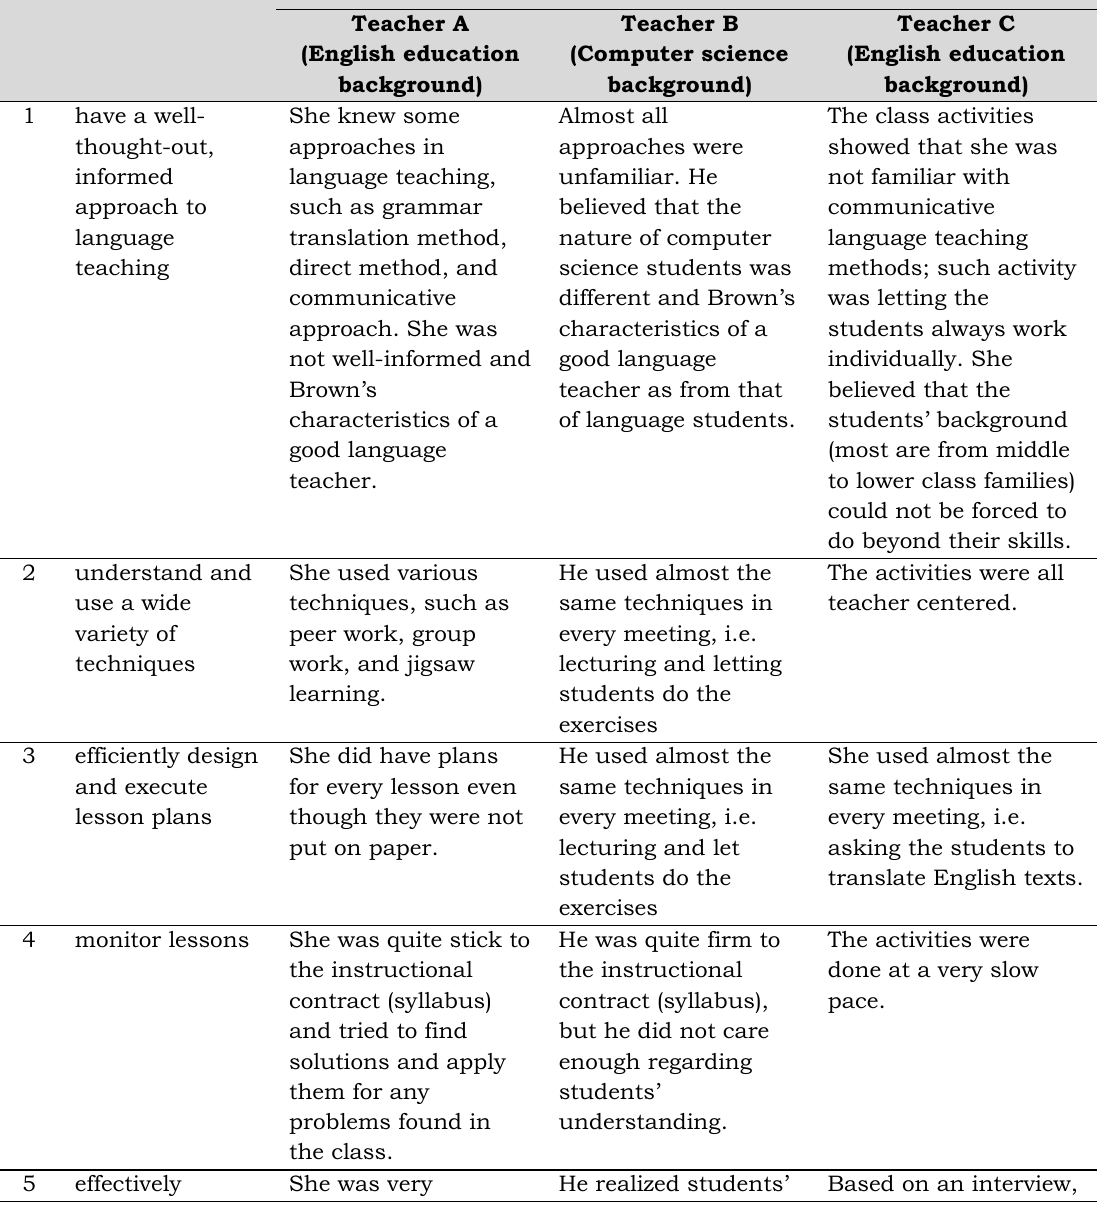
Table 3. Initial pedagogical skills from